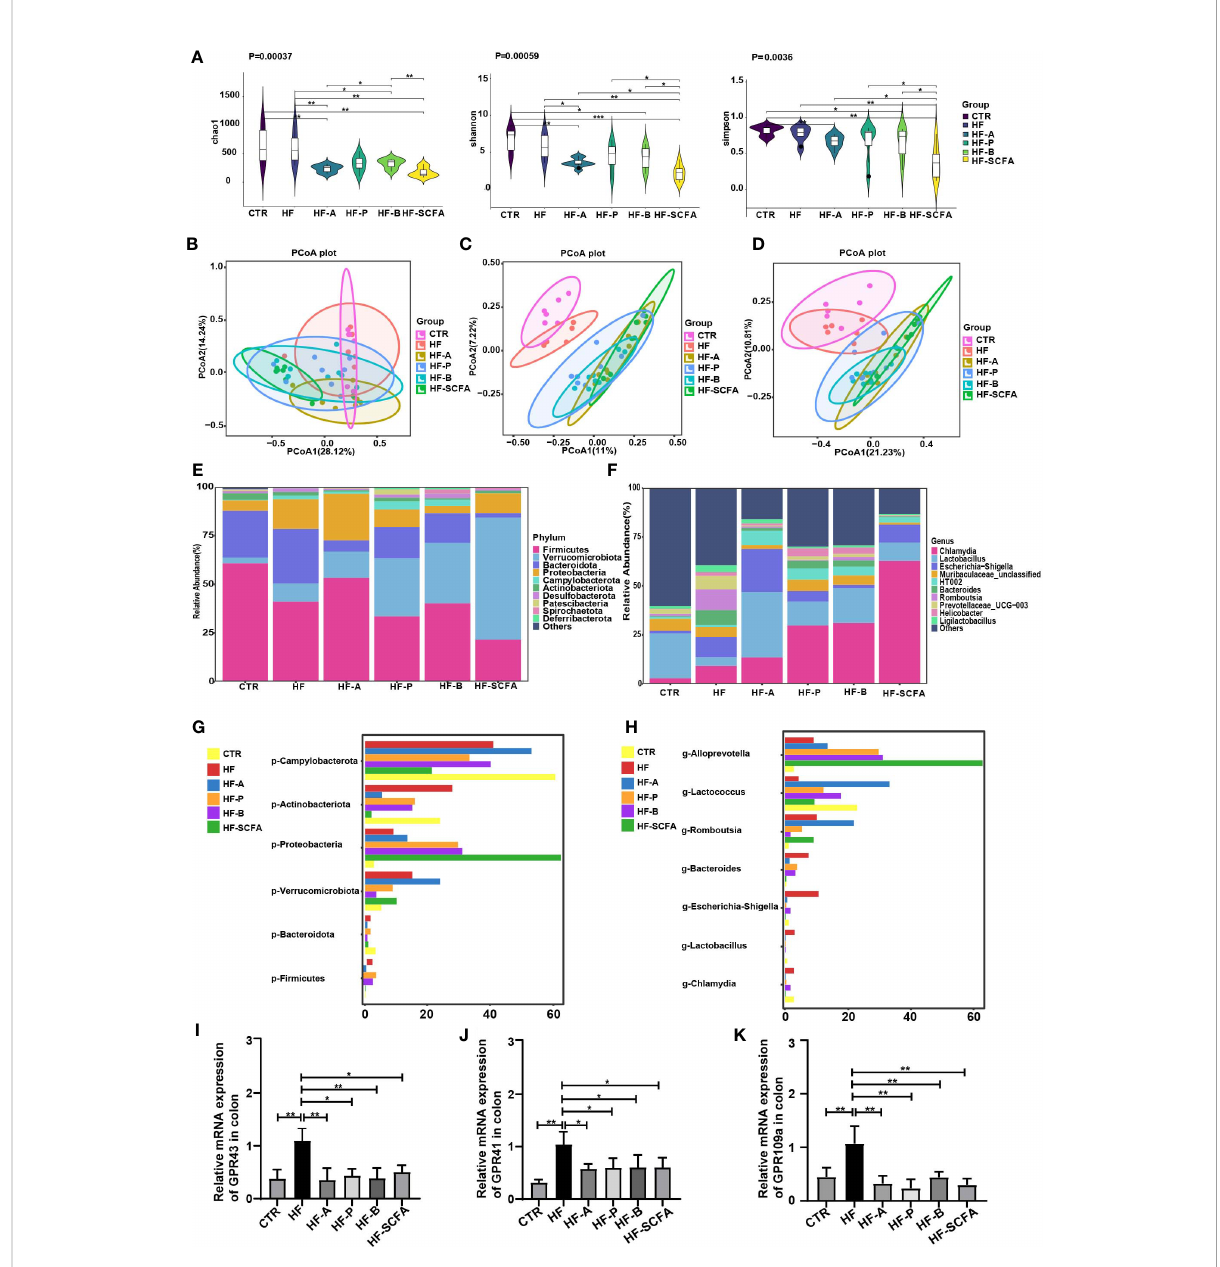
FIGURE 7 SCFAs regulate microbiota and its receptors change in obesity-induced precocious puberty rats. During PND21, female rats were fed HFD, and 5% acetate, propionate, butyrate diet and their mixtures were added until the rats were sacri fi ced during diestrus after completing in estrous cycle. Microbial 16S rDNA genes were subsequently sequenced. (A) a -diversity of the chao1, shannon and simpon index in different groups. (B) PCoA plot of Bray-Curtis distance of the gut microbiota. (C) PCoA plot Jaccard distance of gut microbiota. (D) PCoA plot of unweighted Uni- Frac distance of gut microbiota. (E, F) Community composition distribution at the phylum and genus levels. (G, H) The most differentially abundant proportions between the HF, CTR, HF-A, HF-P, HF-B and HF-SCFA groups at the phylum and genus levels. n=6-8 per group for gut microbiota analysis. Signi fi cances was tested with the Wilcoxon rank-sum test. (I) The gene expression of GPR43 in the colon. (J) The gene expression of GPR41 in the colon. (K) The gene expression of GPR109a in the colon. n = 6 per group for rat samples. * P <0.05; ** P